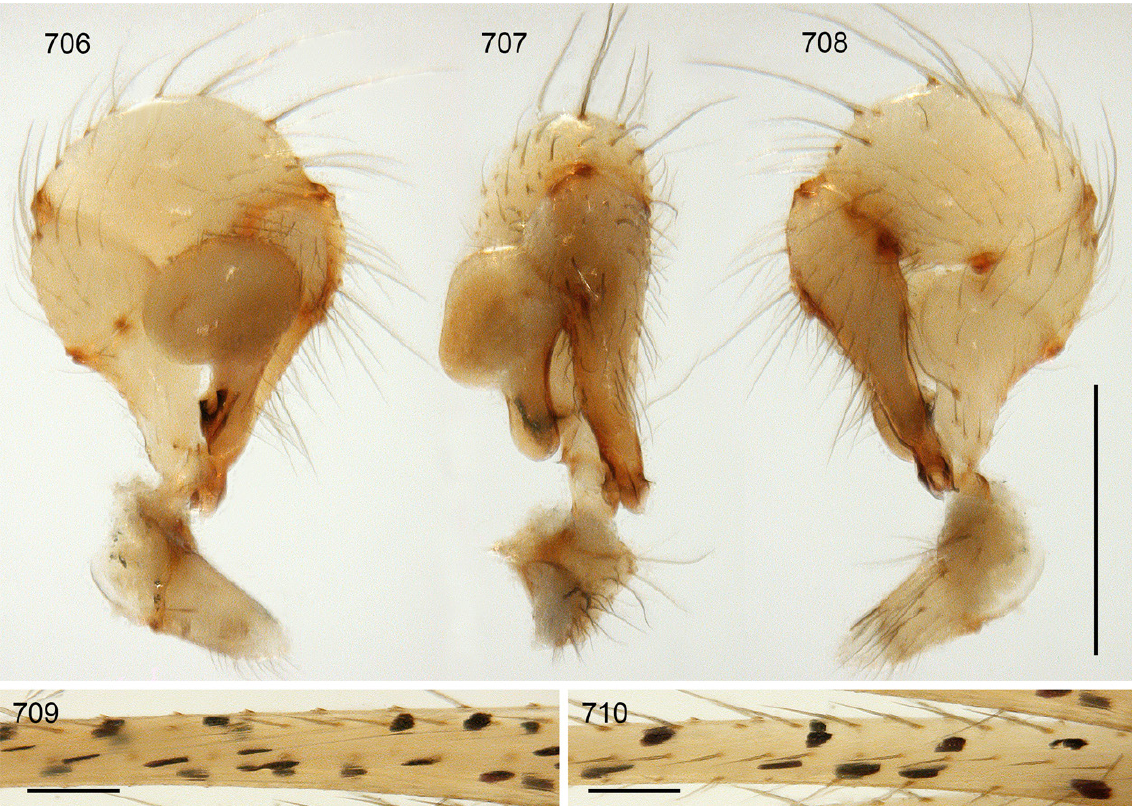
Figs 706–710. Crossopriza miskin sp. nov.; holotype male from Oman, near Miskin (ZFMK Ar 22445) and female from Oman, wadi near Fasah (ZFMK Ar 22447). 706–708 . Left male palp, prolateral, dorsal, and retrolateral views. 709–710 . Female right femora 2 and 3, prolateral views. Scale bars: 706–708 = 0.5 mm; 709–710 = 0.2